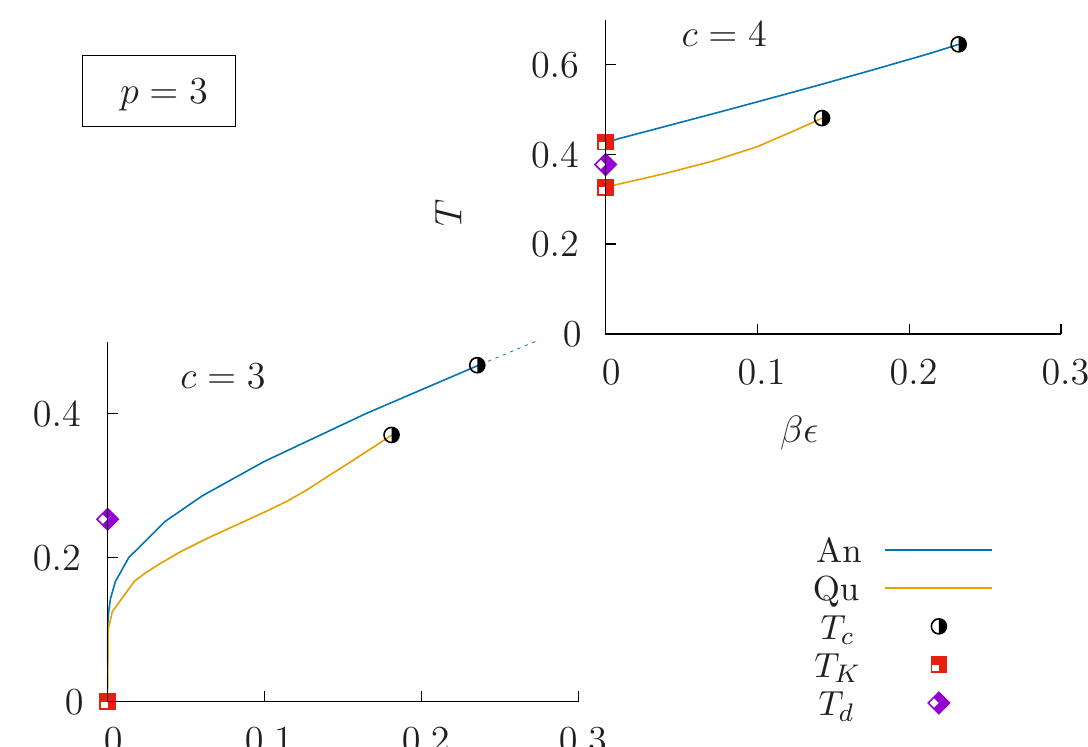
Figure 4: Temperature T versus coupling βε phase diagram for the plaquette spin models with p = 3 in both the annealed and the quenched descriptions on Bethe hyper-lattices with c = 3 and c = 4 ( c = 2 corresponds to the 1-dimensional chain and is of no interest here). The interaction strength J is set equal to 1. The dashed line is the continuation of the self-dual line (see